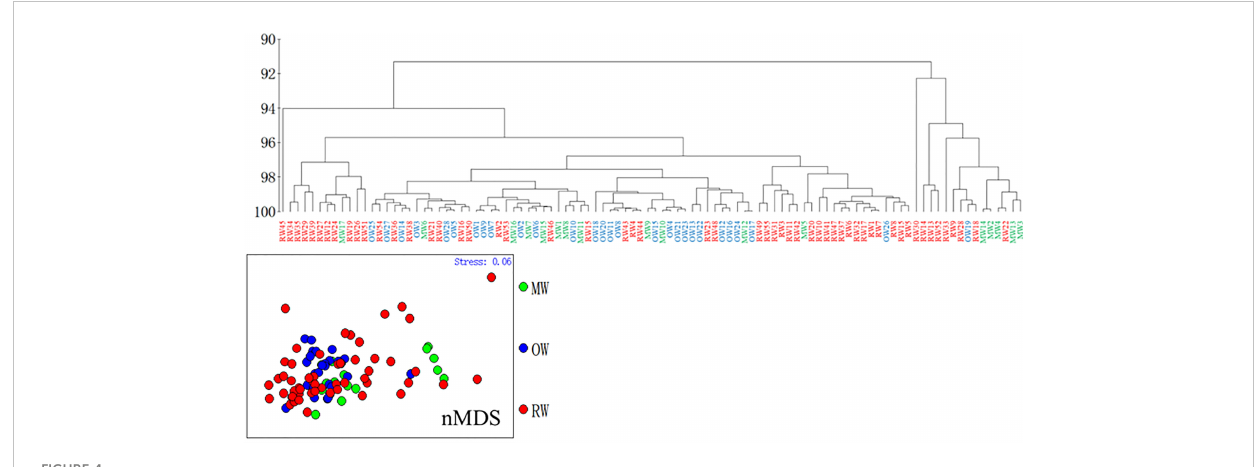
FIGURE 4 Cluster analysis and nMDS based on otolith core chemistry (stress <